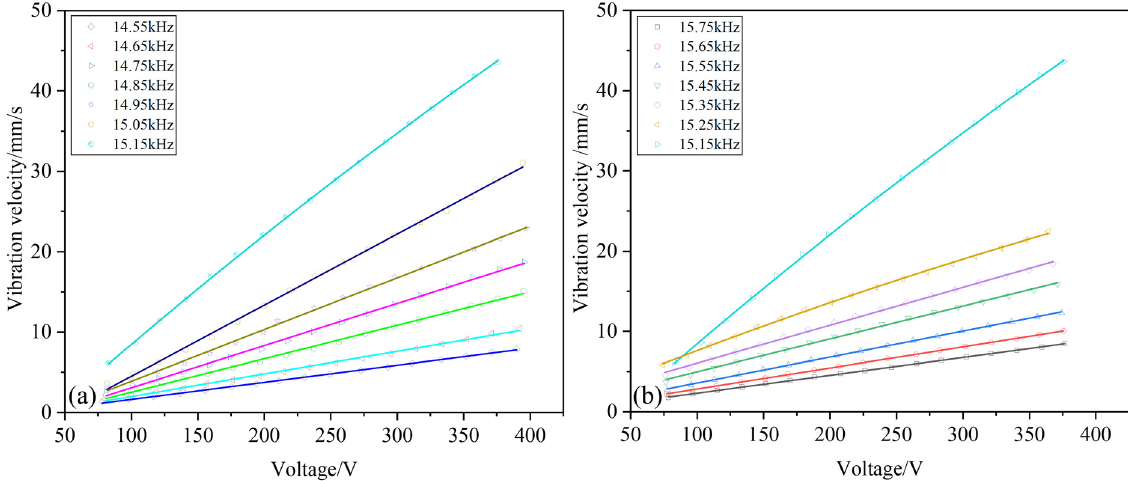
Figure 10. Voltage response curve of frequency for piezoelectric transducer near 15.15 kHz: ( a ) diagram of voltage-frequency relationship in 14.55–15.15 kHz frequency, ( b ) diagram of voltage-frequency relationship in 15.15–15.75 kHz frequency.